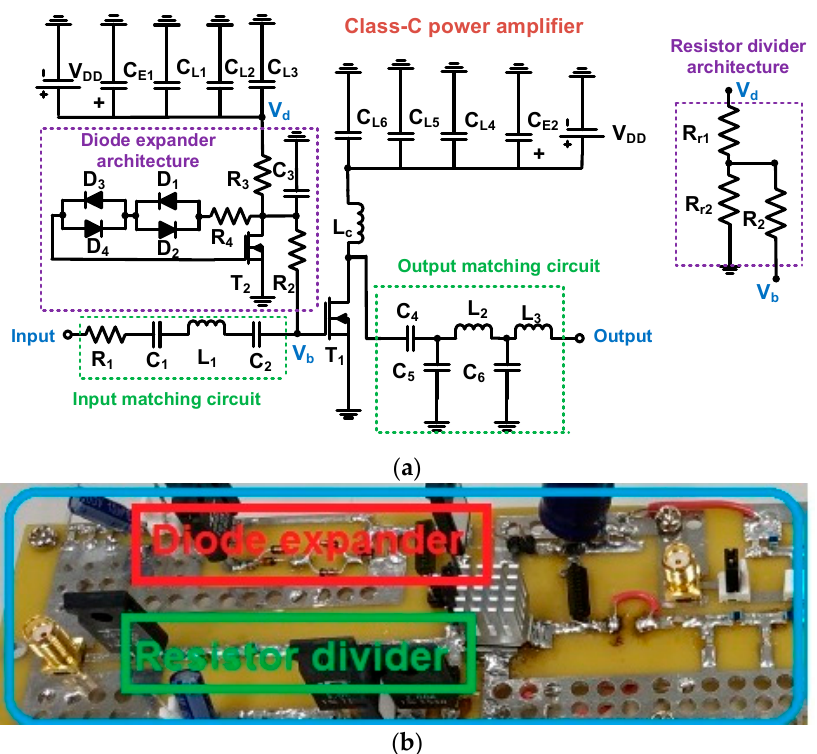
Figure 2. ( a ) Schematic diagram and ( b ) implemented printed circuit board of the developed class-C power amplifier with a resistor divider and diode expander architecture.